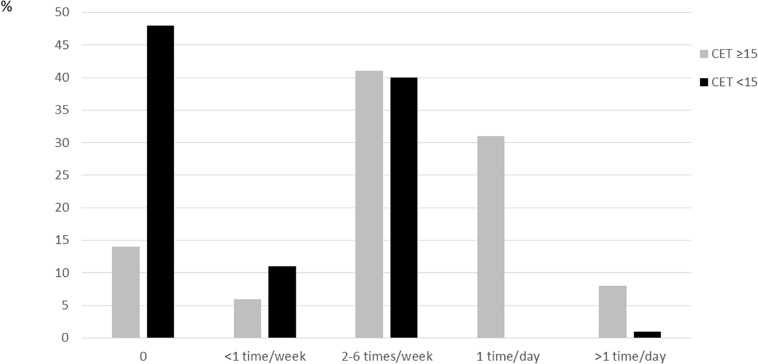
Proportion of subjects with high (≥15) or low (<15) CET-score across frequency of exercise, from 0 to >1 time/day.